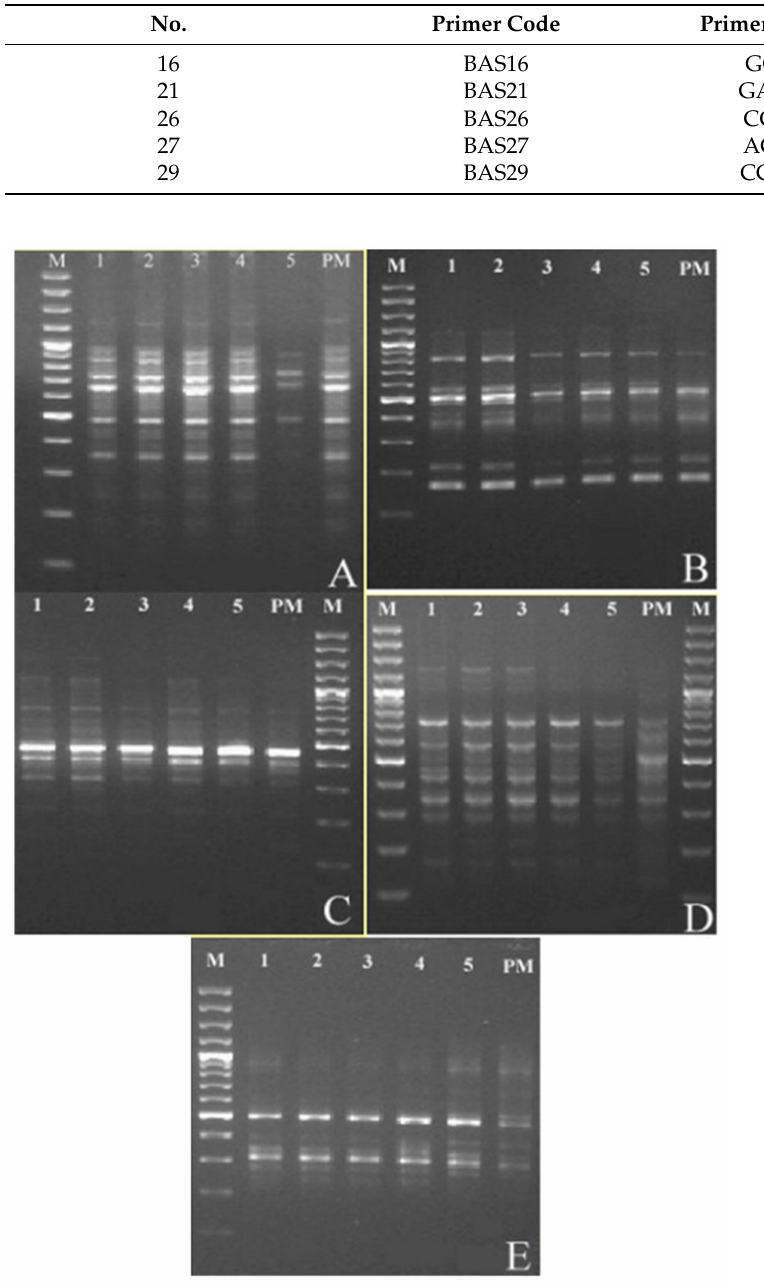
Figure 4. Randomly amplified polymorphic DNA profiles obtained by PCR amplification of